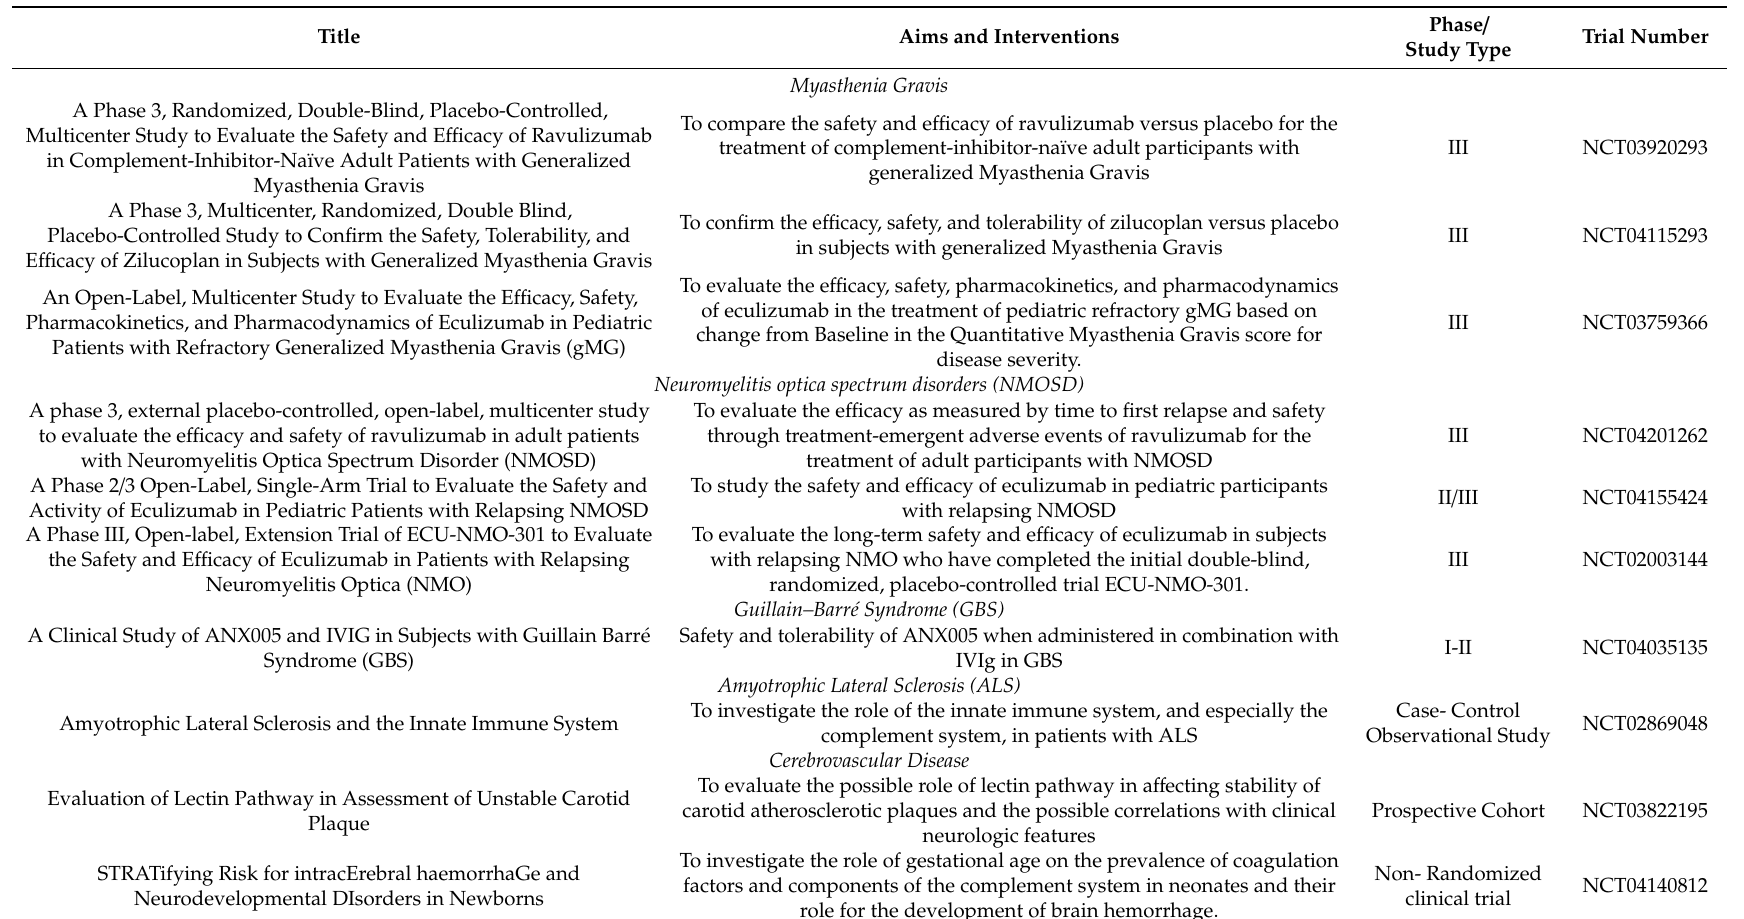
Table 2. Summary of ongoing clinical trials investigating complement therapeutic targets and the role of the complement system in neurologic